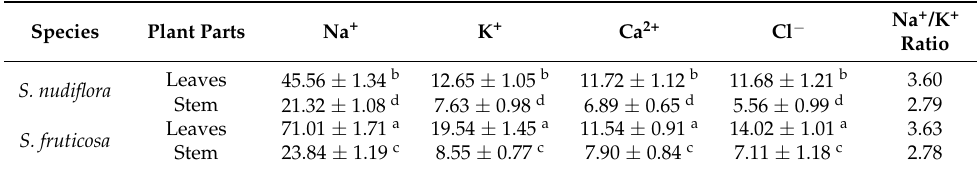
Table 2. Deposition of various ions in leaves and stem parts of the